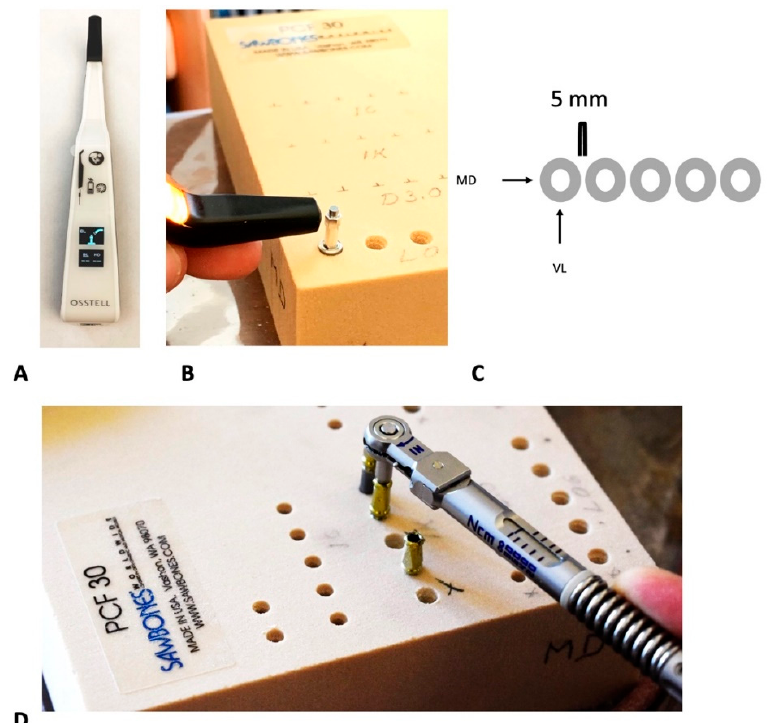
Figure 1. Evaluation of the primary stability of the two types of implants by means of the RFA measurement ( A , B ) that was performed in two different directions ( C ), and the recording of the insertion torque value (ITV) and removal torque value (RTV) by using a specific dynamometric ratchet CRD ( D